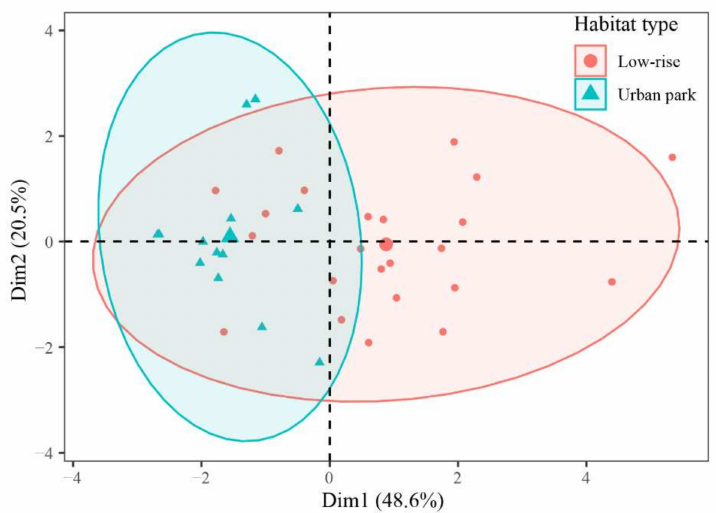
Figure 5. Plot of the PCA of song similarity of individuals between low-rise residential areas and urban parks by the first 2 PCA